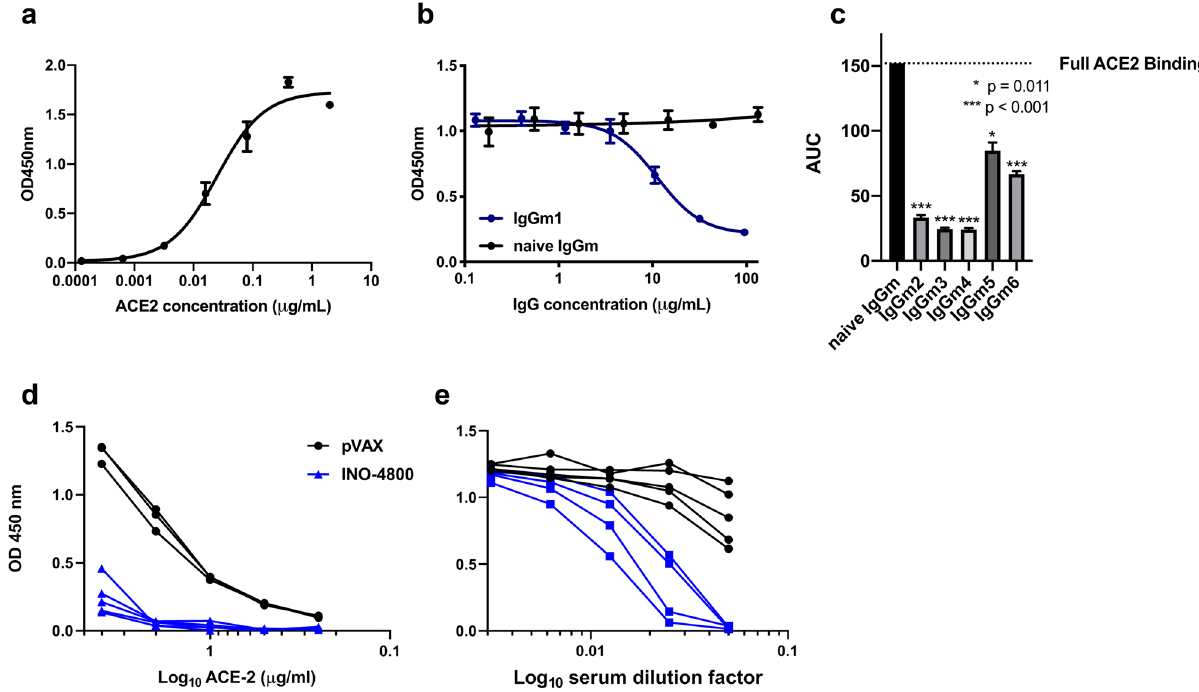
Fig. 6 INO-4800 immunized mouse and guinea pig sera compete with ACE2 receptor for SARS-CoV-2 Spike protein binding. a Soluble ACE2 receptor binds to CoV-2 full-length spike with an EC 50 of 0.025 µ g/ml. b Puri fi ed serum IgG from BALB/c mice ( n of 5 per group) after second immunization with INO-4800 yields signi fi cant competition against ACE2 receptor. Serum IgG samples from the animals were run in triplicate. c IgGs puri fi ed from n = 5 mice day 7 post second immunization with INO-4800 show signi fi cant competition against ACE2 receptor binding to SARS-CoV-2 S 1 + 2 protein. The soluble ACE2 concentration for the competition assay is ~0.1 µ g ml − 1 . Bars represent the mean and standard deviation of AUC for curves displayed in Supplementary Fig. 1. d Hartley guinea pigs were immunized on Day 0 and 14 with 100 µ g INO-4800 or pVAX-empty vector as described in the methods. Day 28 collected sera (diluted 1:20) was added SARS-CoV-2 coated wells prior to the addition of serial dilutions of ACE2 protein. Detection of ACE2 binding to SARS-CoV-2 S protein was measured. Sera collected from 5 INO-4800-treated and 3 pVAX-treated animals were used in this experiment. e Serial dilutions of guinea pig sera collected on day 21 were added to SARS-CoV-2 coated wells prior to the addition of ACE2 protein. Detection of ACE2 binding to SARS-CoV-2 S protein was measured. Sera collected from 4 INO-4800-treated and 5 pVAX-treated guinea pigs were used in this